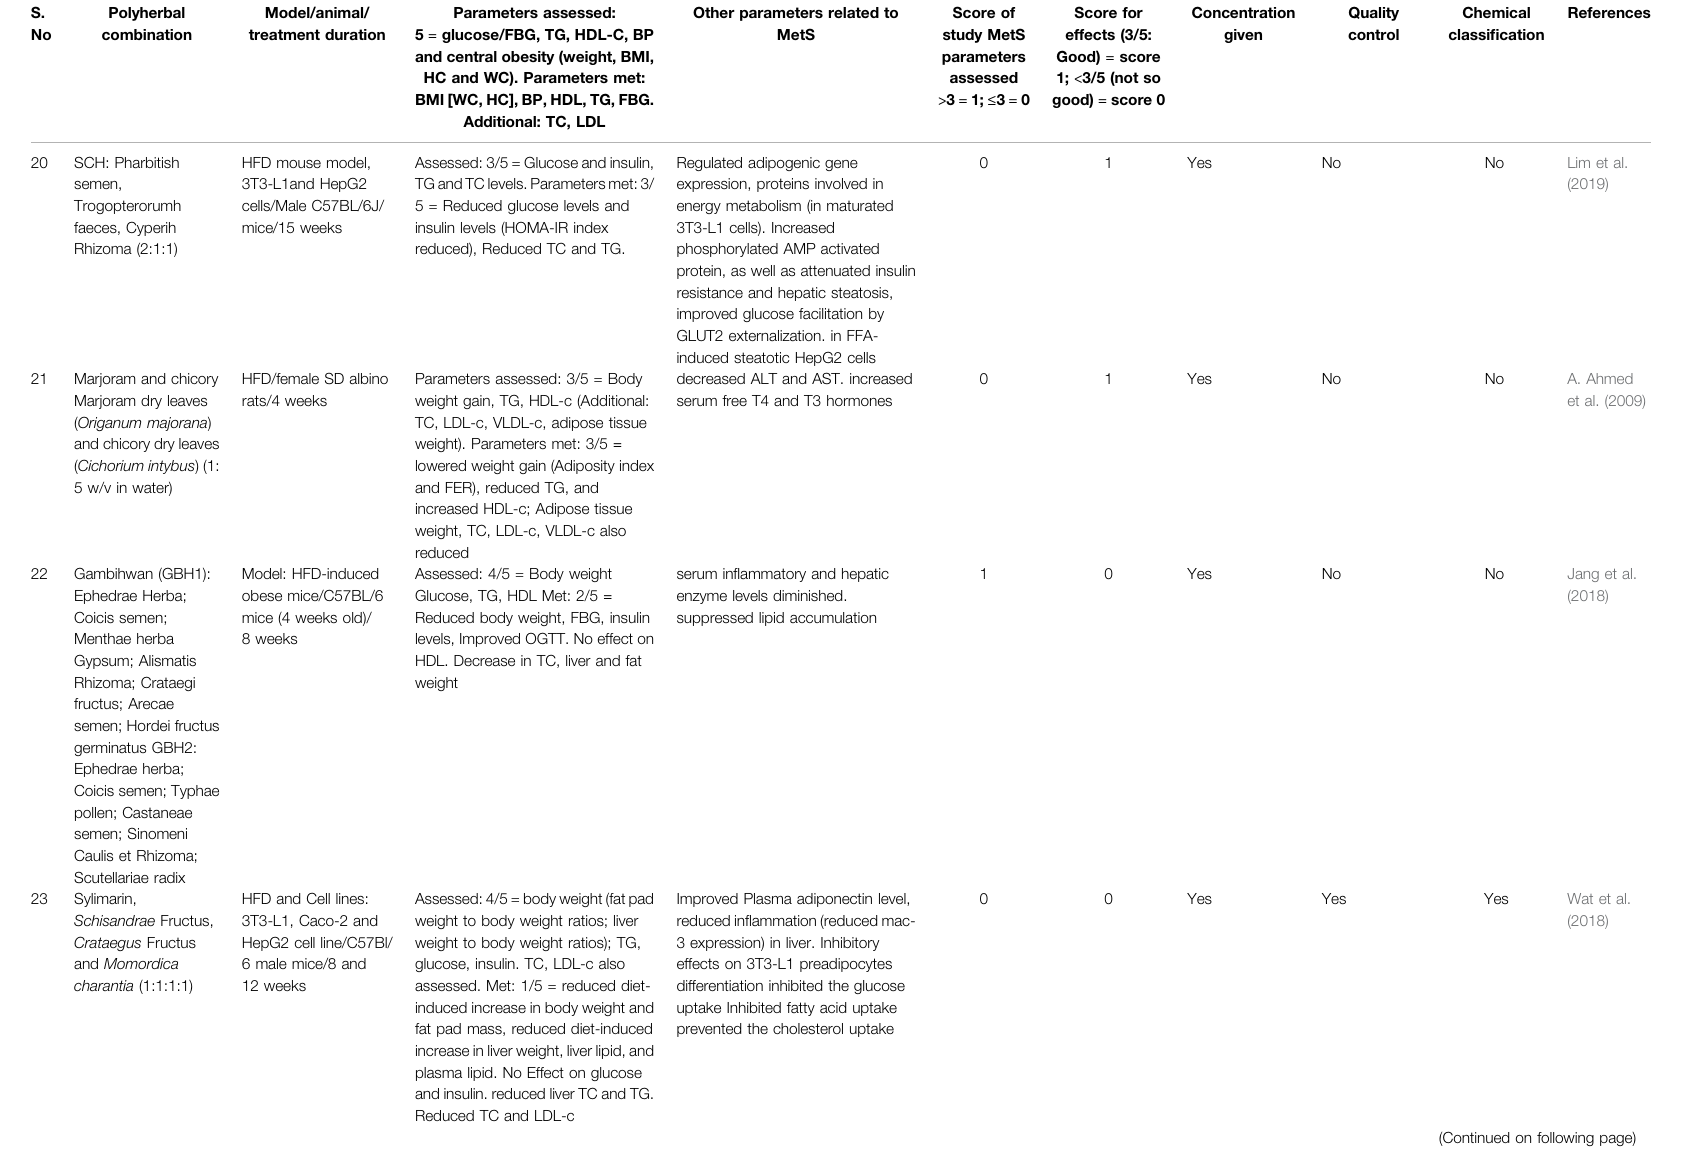
TABLE 3 | ( Continued ) Summary of metanalysis of Poly herbal combinations used in animal-based models of Metabolic syndrome. S.